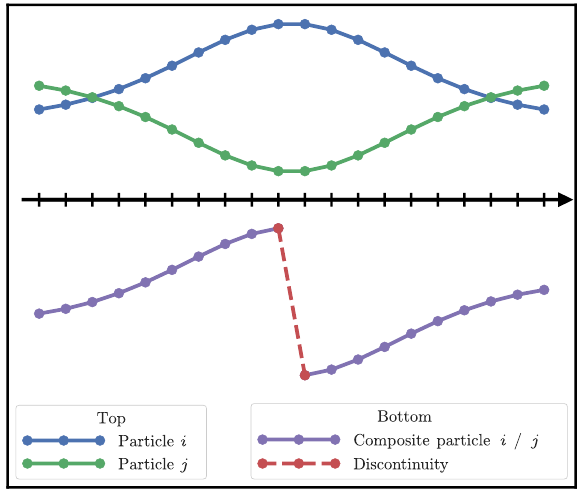
Figure 3. Example of one-dimensional concatenation of particle i on the left and particle j on the right. The composite particle (pur- ple) is a concatenation of particles i (blue) and j (green). In this situation, a large unphysical discontinuity appears at the